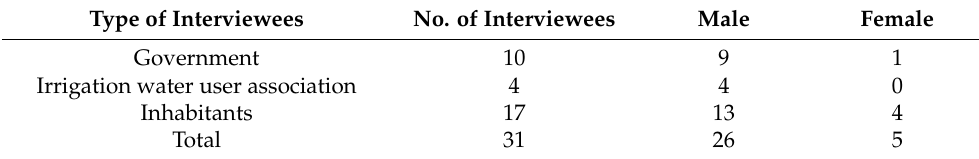
Table 1. Number of interviewees by type and sex (Luis Miguel Silva-Novoa